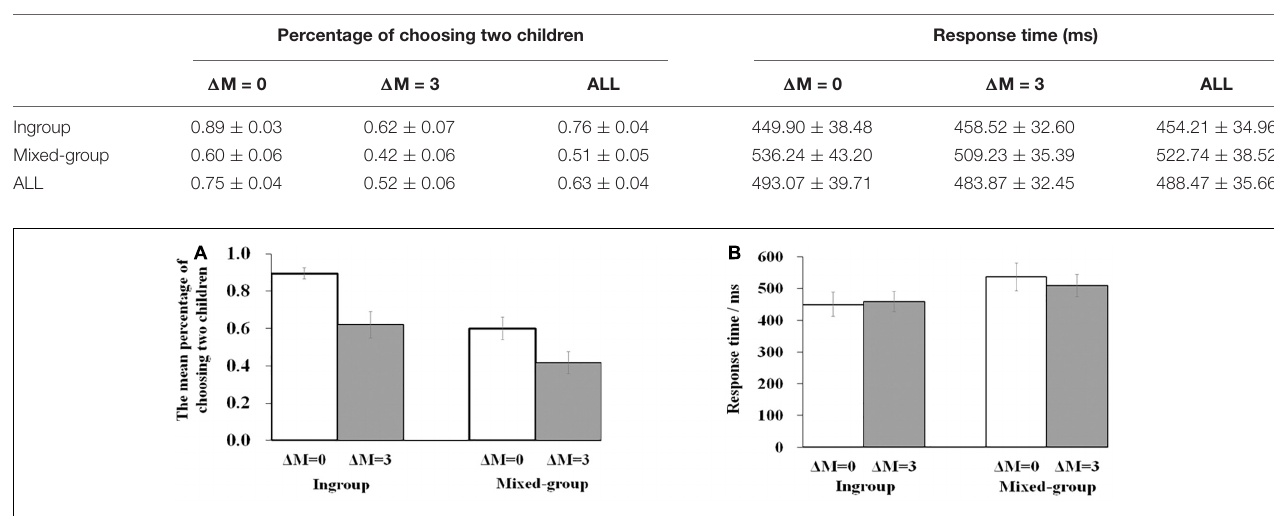
FIGURE 2 | (A) The mean percentage of choosing two children for four (2 × 2) kinds of stimuli (ingroup and (cid:49) M = 0; ingroup and (cid:49) M = 3; mixed-group and (cid:49) M = 0; mixed-group and (cid:49) M = 3). (B) The mean response time for four (2 × 2) kinds of stimuli. Bars represented standard error. Levels of significance:* p < 0.05; ** p < 0.01; *** p <